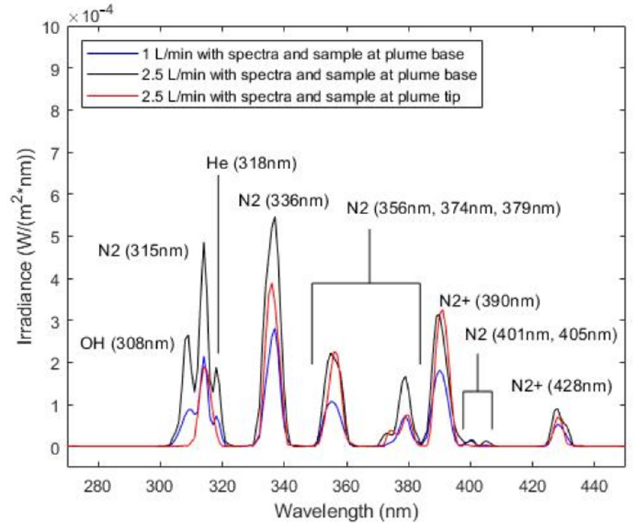
Figure 2. Optical Emission Spectroscopy (OES) spectra of the plasma plume with the UHMWPE sample present at its treatment locations and with its treatment flow